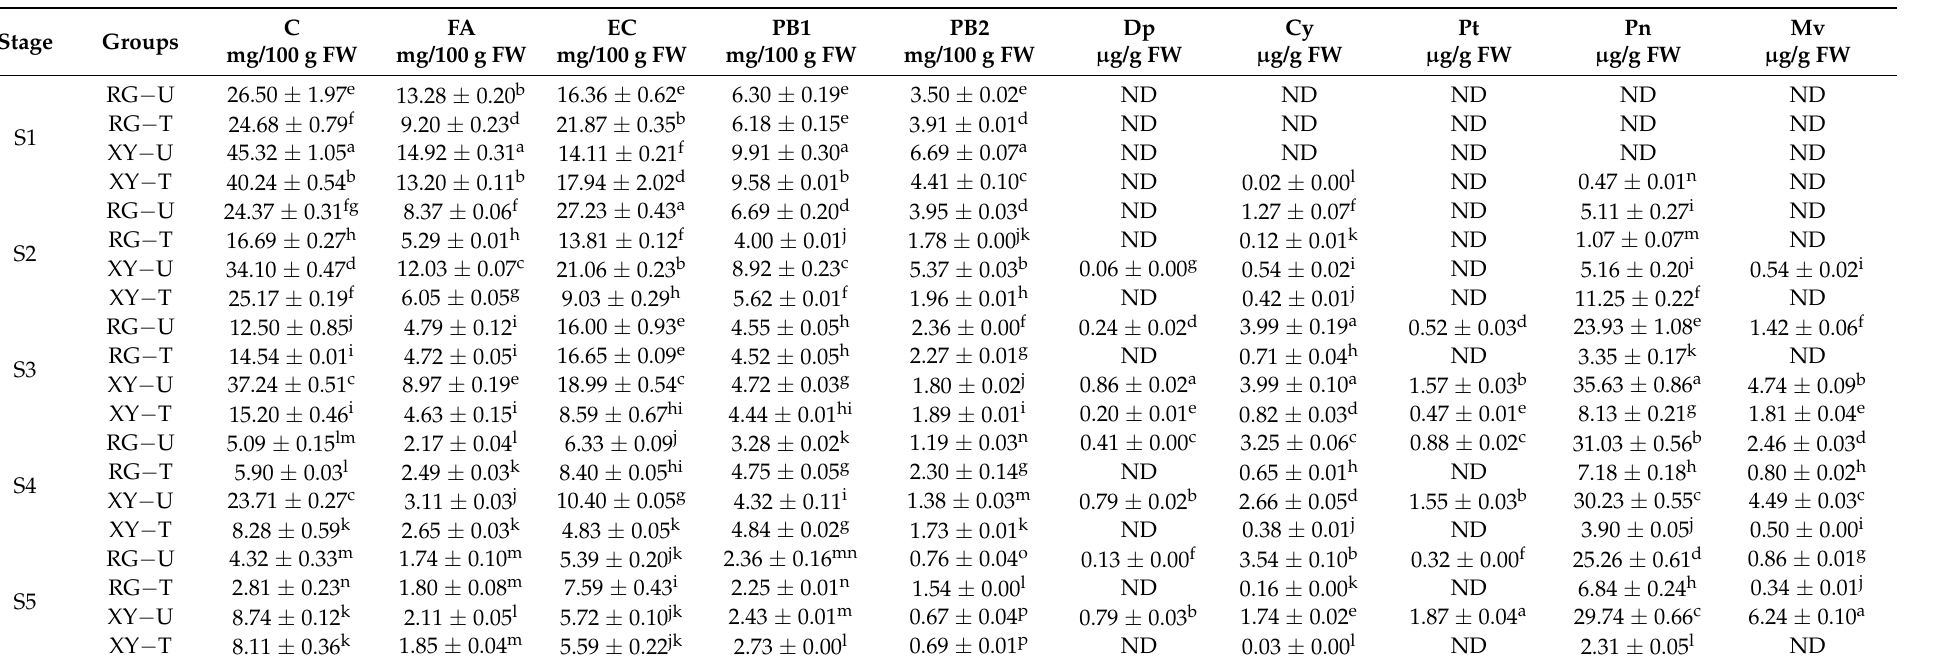
Table 1. Changes in phenolic and anthocyanin profiles in grape berries during the five developmental stages in Urumqi and Turpan (S1, S2, S3, S4, and S5).